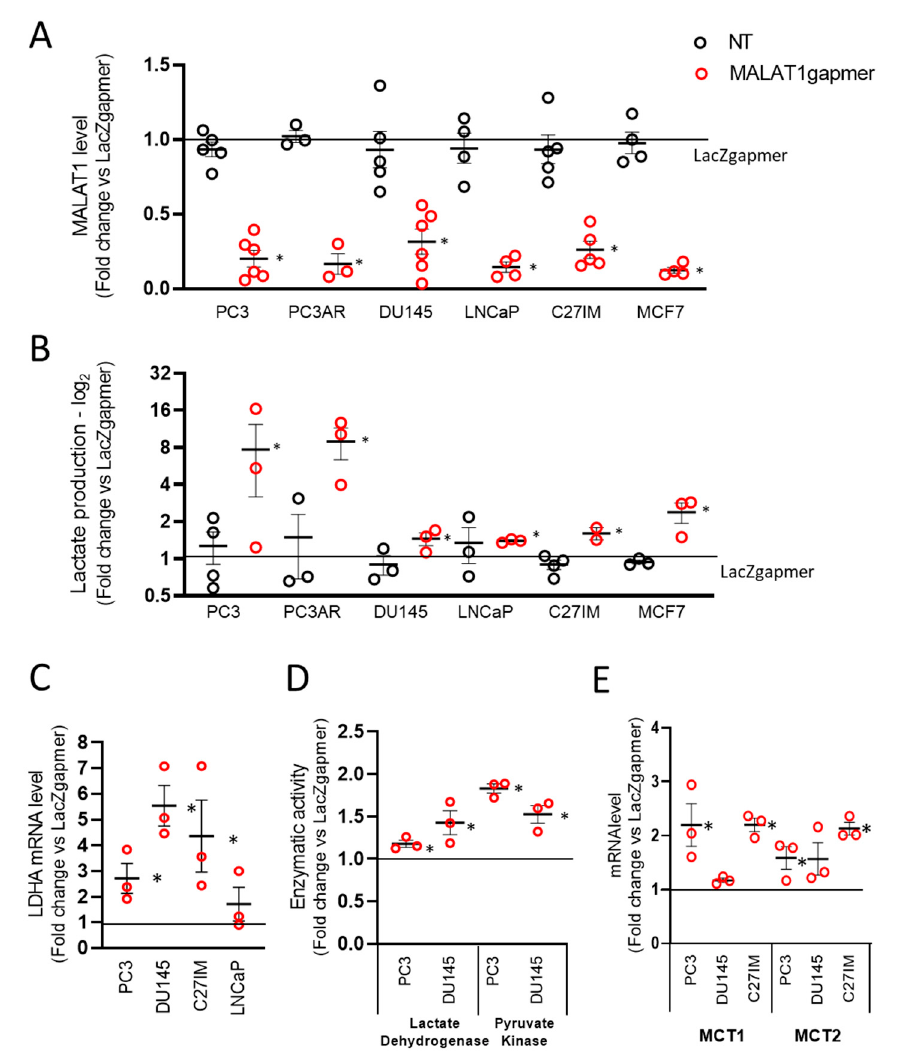
Figure 1. Effects of metastasis-associated lung adenocarcinoma transcript 1 (MALAT1) depletion in prostate cancer cells. ( A ) MALAT1 expression was quantified by qRT-PCR in five different prostate cancer (PC3 n = 6, PC3AR n = 3, DU145 n = 6, LNCaP n = 4, and C27IM n = 5) and one breast cancer (MCF7 n = 4) cell lines at 72 h after transfection with specific (MALAT1), control (LacZ), or no (NT) gapmers. ( B ) Lactate concentration determined by a colorimetric assay in the cell culture supernatant of PC3, PC3AR, DU145, LNCaP, C27IM, and MCF7 cells after MALAT1 gapmerization as in panel A ( n = 3 or 4). Samples were collected after 48 h from transfection. ( C , E ) mRNA levels of lactate dehydrogenase A (LDHA, n = 3, C) and monocarboxylate transporter 1 and 2 (MCT1 and MCT2, n = 3, D) were quantified by qRT-PCR in PCa cells at 72 h after transfection with MALAT1 or LacZgapmers. ( D ) Enzymatic activity of lactate dehydrogenase and pyruvate kinase measured in PC3 ( n = 3) cells 24 h after transfection with MALAT1 or LacZgapmers. Results are depicted as fold induction vs. LacZgapmer taken as 1 (black straight line). Individual values with mean +/ − SEM are shown (red circles for MALAT1 gapmer, black circles for untreated cells, NT). Non-parametric paired two-tailed Student’s t -test determined statistical significance. * p ≤ 0.05 MALAT1gapmer vs. LacZgapmer.